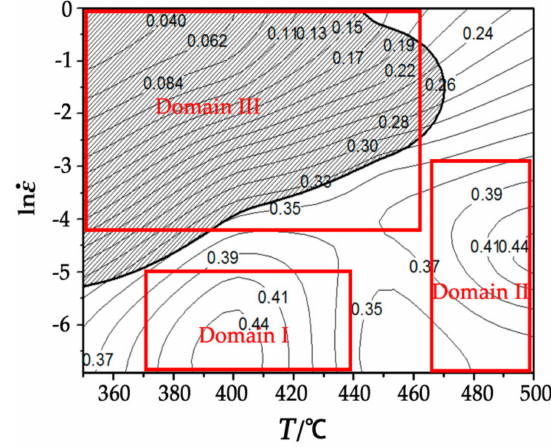
Figure 10. Processing map with the strain of 0.5.